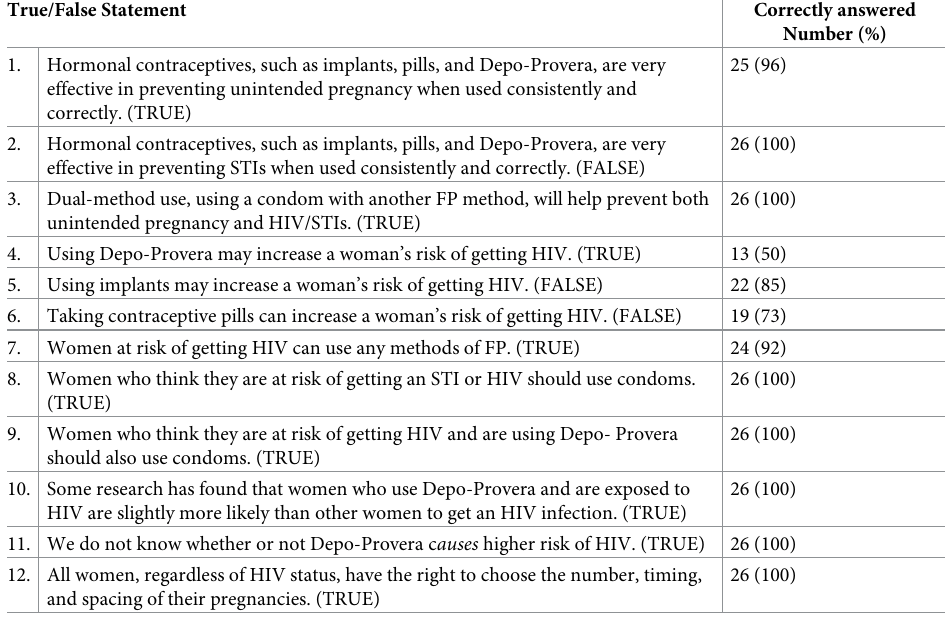
Table 7. Providers’ knowledge of HC/HIV counseling messages: True/false number and percent distribution of correct knowledge of HC-HIV counseling messages among twenty-six trained healthcare providers, Tanzania